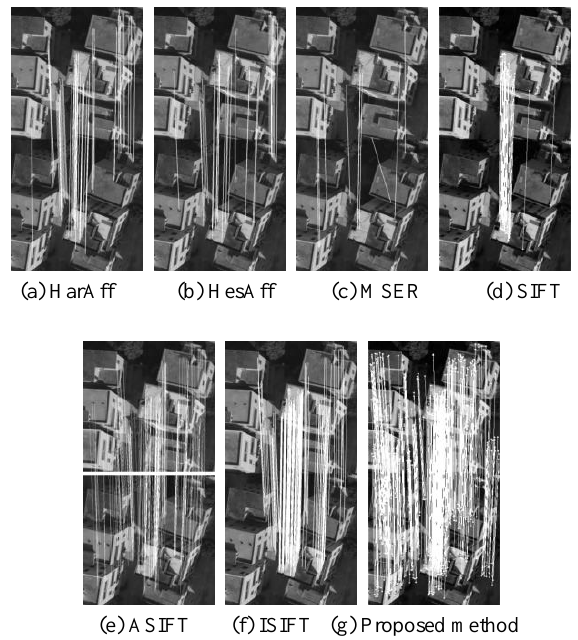
Figure 9. Matching results based on Dataset 1.